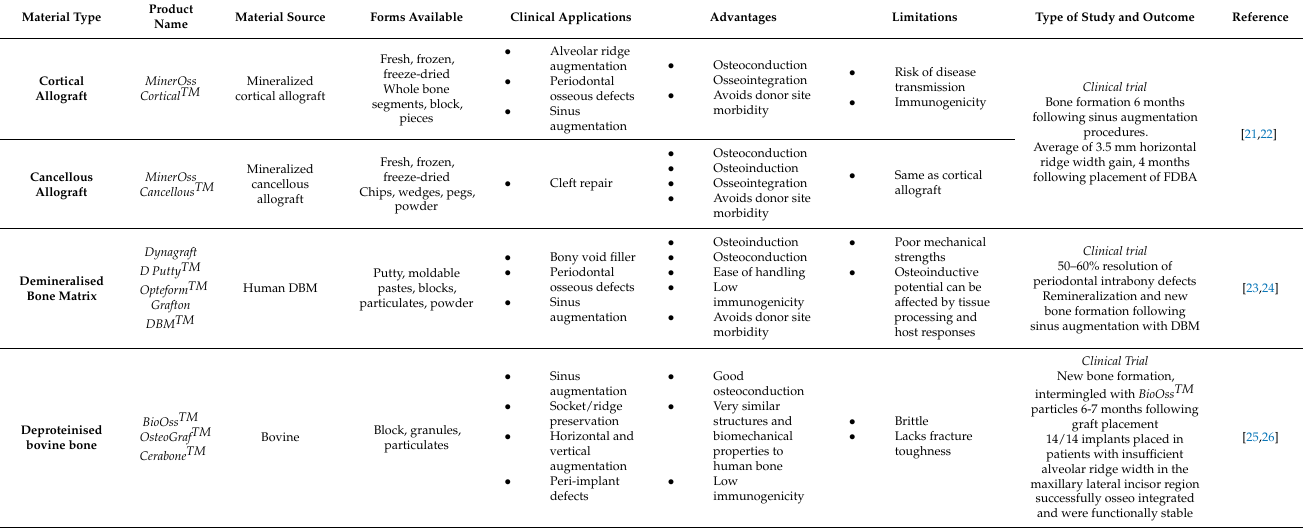
Figure 2. Classification of bone graft and substitute materials used in dentistry, broadly classified into five categories and showing their associated sub-categories. Table 1. Characteristics of commercially available natural bone graft and substitute